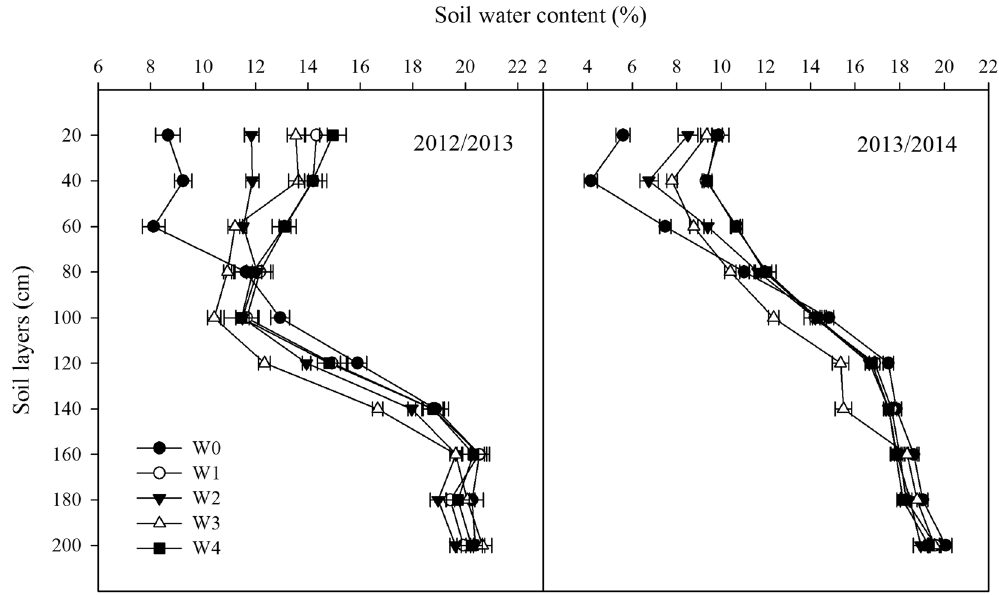
Figure 1. The soil water content at maturity of different treatments in 2012/2013 and 2013/2014 growing seasons. The horizontal bars represent standard error of the mean (n =